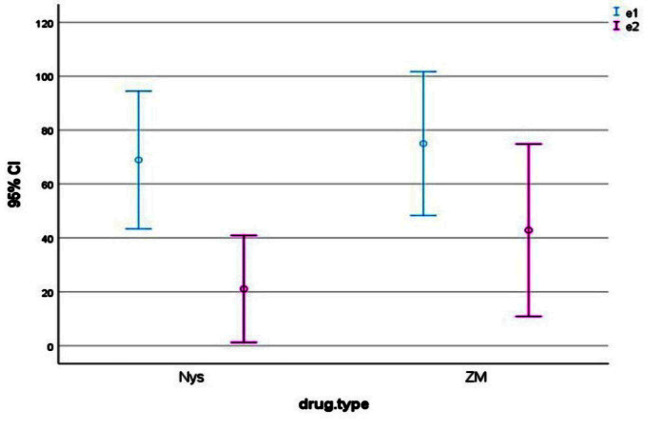
 Erythema before and after treatment in the two groups